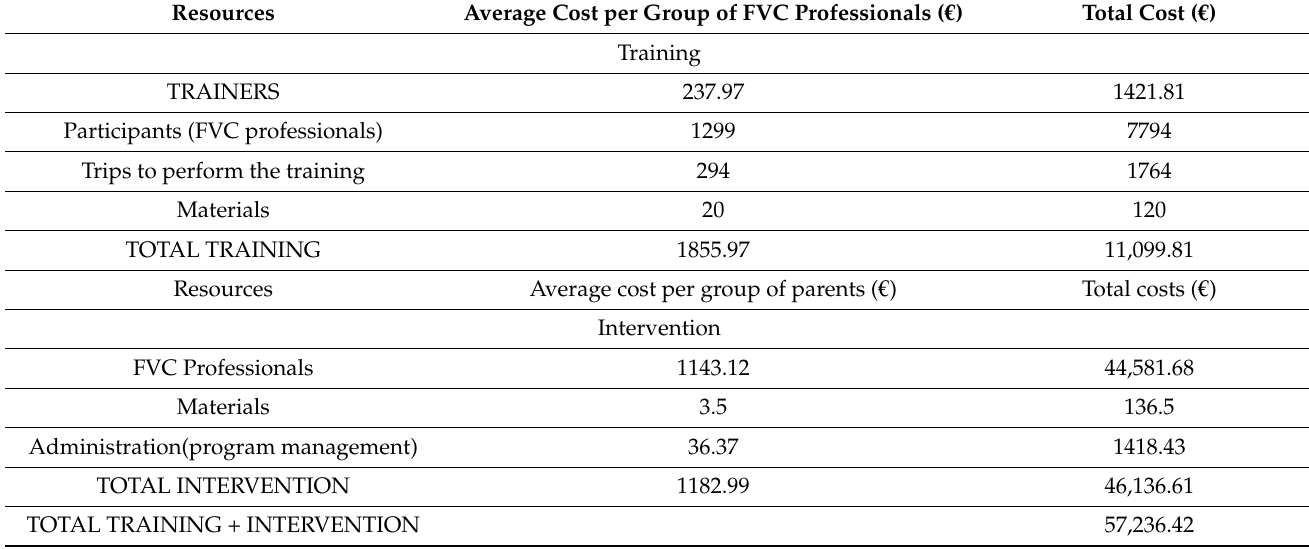
Table 3. Average cost per group and total cost of the training and intervention